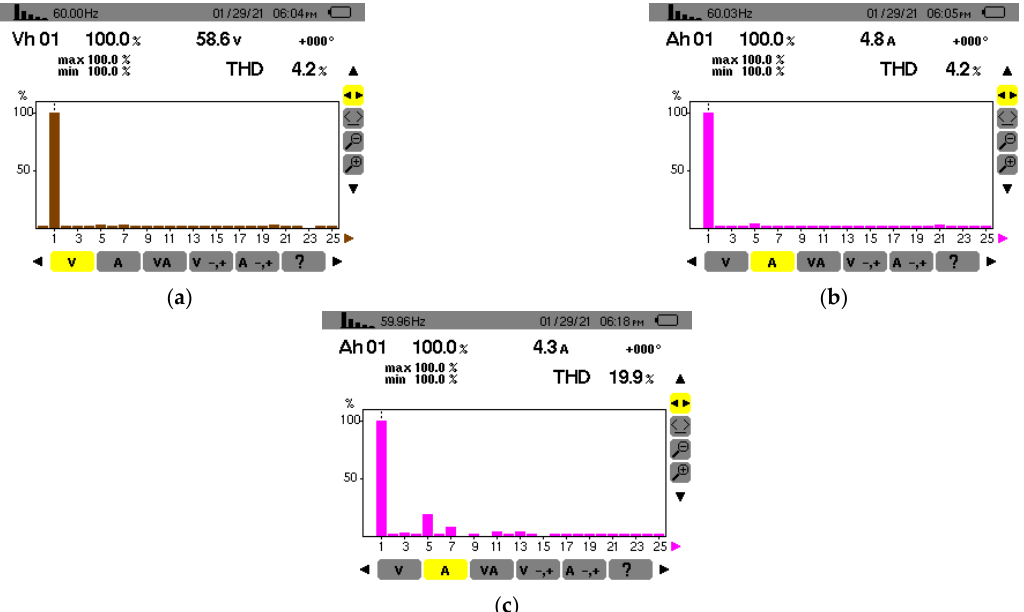
Figure 13. THD of the PCC voltage ( a ), DG current ( b ) and load current ( c ).